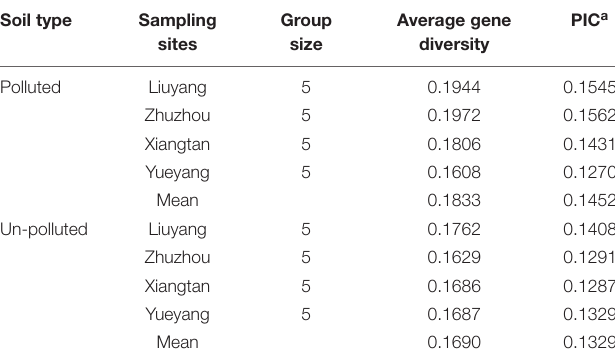
TABLE 6 | Genetic diversity within